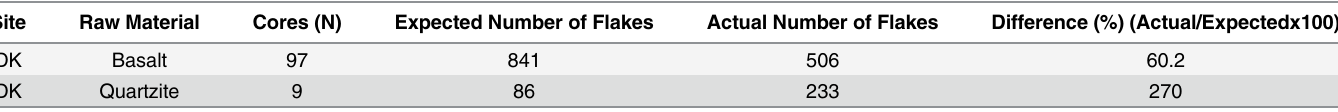
Table 5. Archaeological samples of cores per site compared to the experimentally determined expectations of flakes per core (see Table 4) and the actual number of archaeological flakes recovered from the